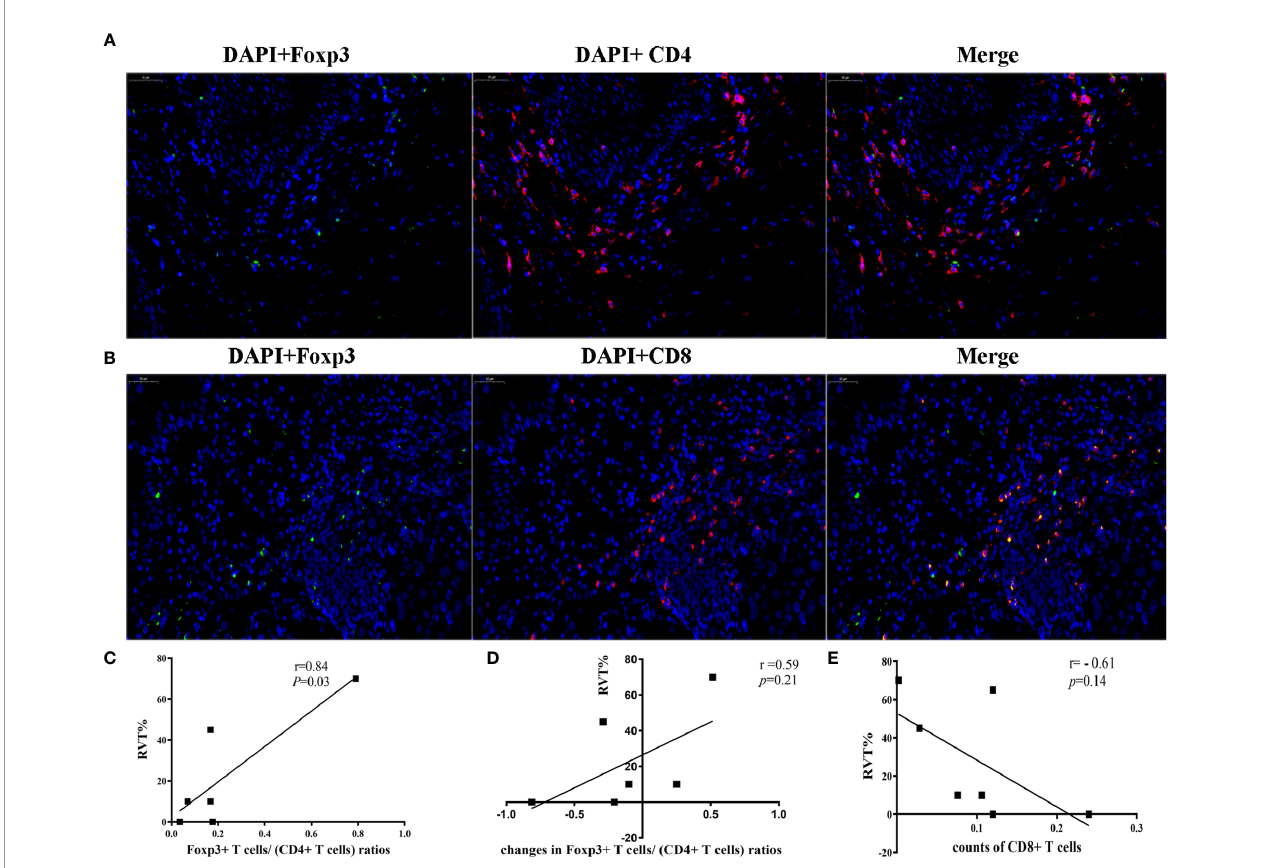
FIGURE 7 | Correlation between immune cells and RVT. (A) Two-color immuno fl uorescence analysis showing the expression of CD4, Foxp3. DAPI (blue), CD4 (red) and Foxp3 (green); (B) Two-color Immuno fl uorescence analysis showing the expression of CD8, Foxp3. DAPI (blue), CD8 (red) and Foxp3 (green); (C) correlation analysis between postoperative Foxp3 + T cells/(CD4 + T cells) ratios and RVT; (D) correlation analysis between changes in Foxp3 + T cells/(CD4 + T cells) ratios and RVT; (E) correlation analysis between the counts of postoperative CD8 + T cells and RVT. RVT, residual viable tumor; DAPI, DAPI (4 ’ ,6-diamidino-2-phenylindole) fl uorescence marking the cell